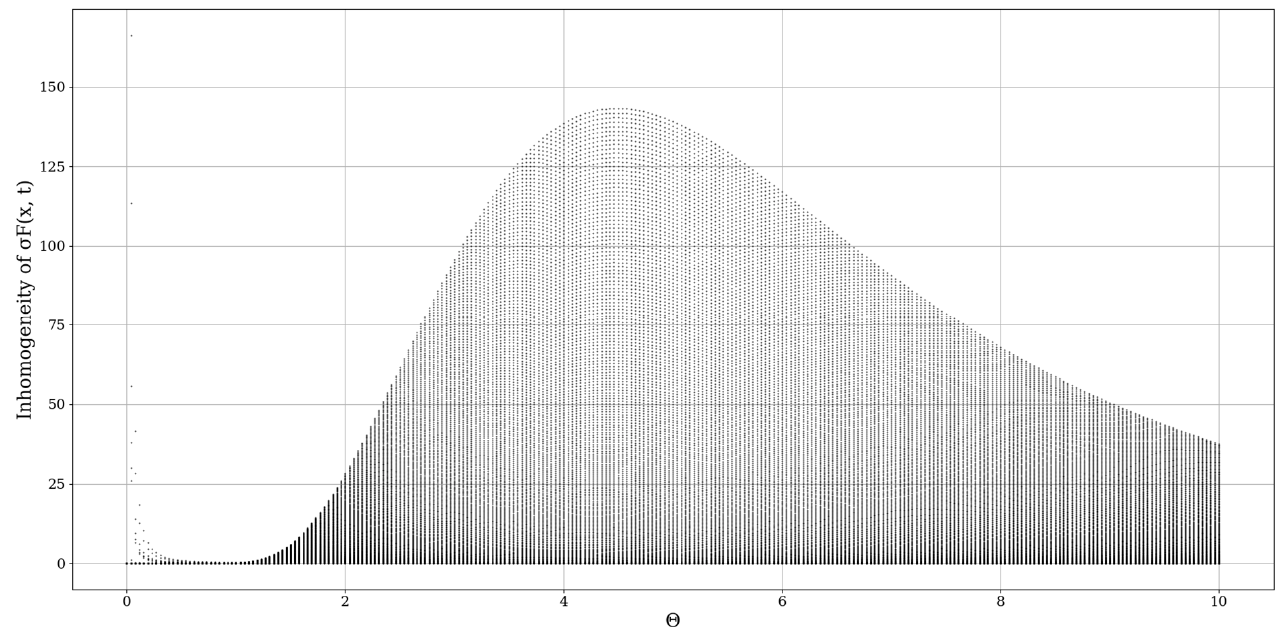
(cid:48) 2 (cid:105) Figure 10. (cid:104)| σ F | example plot with θ as control parameter; ξ = 3; µ = Figure 10. 〈|σ (cid:2890) (cid:3364)(cid:3364)(cid:3364)| (cid:4593)(cid:2870) 〉 example plot with θ as control parameter; ξ = 3 ; μ = 3 .